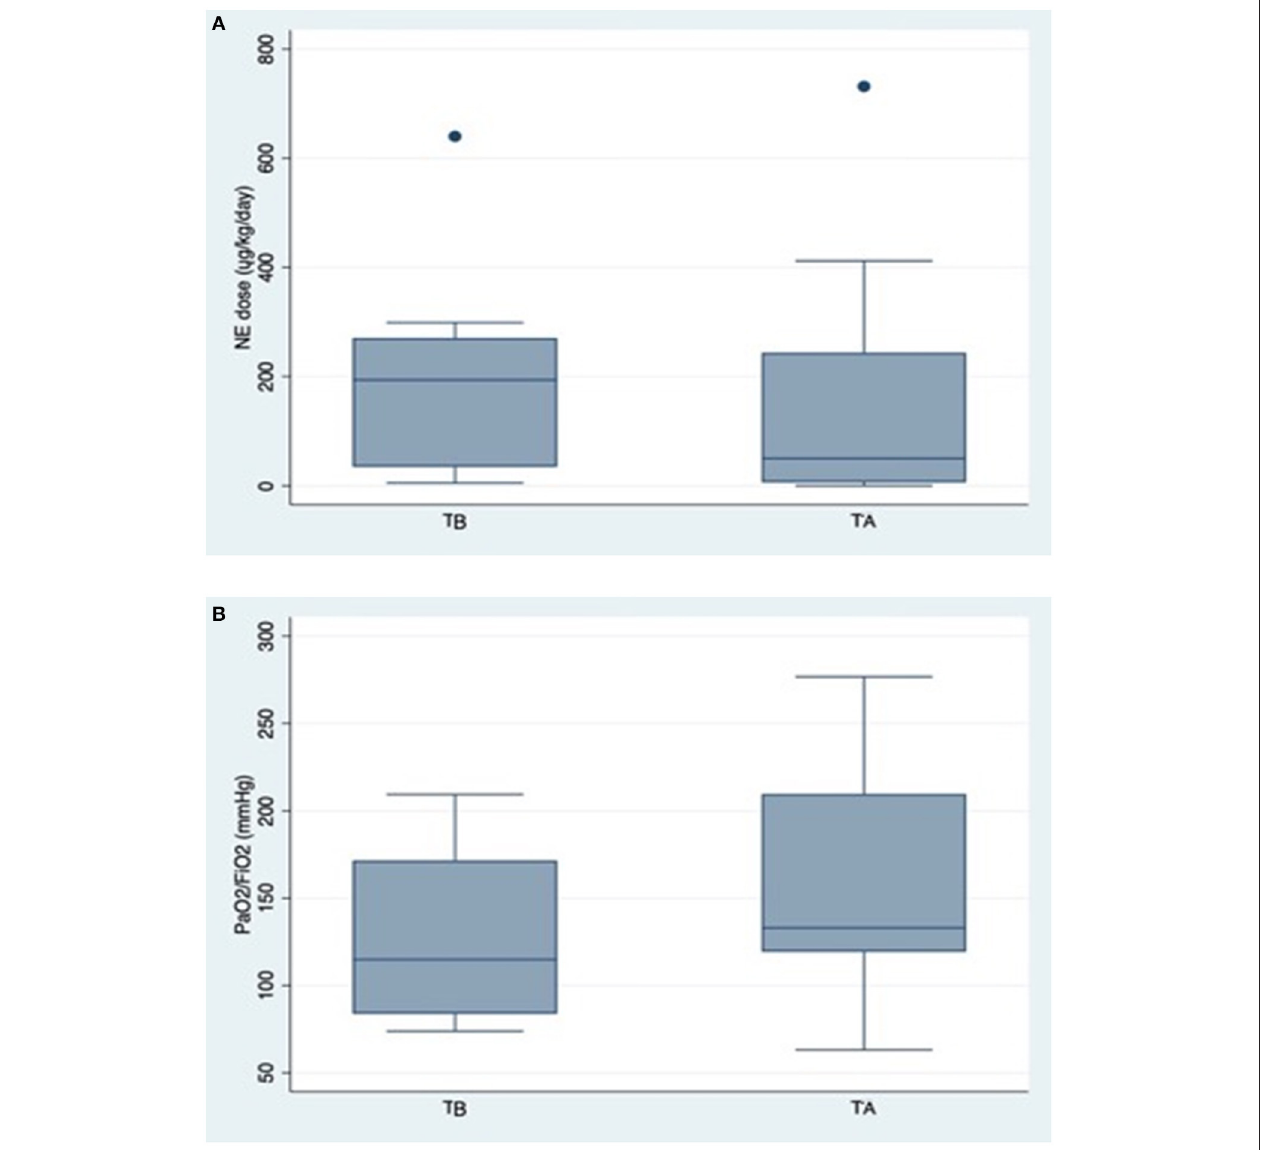
FIGURE 1 | (A) Change in norepinephrine requirement during hemoadsorption. NE, Norepinephrine; TB, data collected before the start of hemoadsorption; TA, data collected after the completion of hemoadsorption. Data are presented as box-plots. For statistical analysis Stata 15.1 was used. For explanation see main text. (B) Change in the PaO2/FiO2 ratio during hemoadsorption. TB, data collected before the start of hemoadsorption; TA, data collected after the completion of hemoadsorption. Data are presented as box-plots. For statistical analysis Stata 15.1 was used. For explanation see main